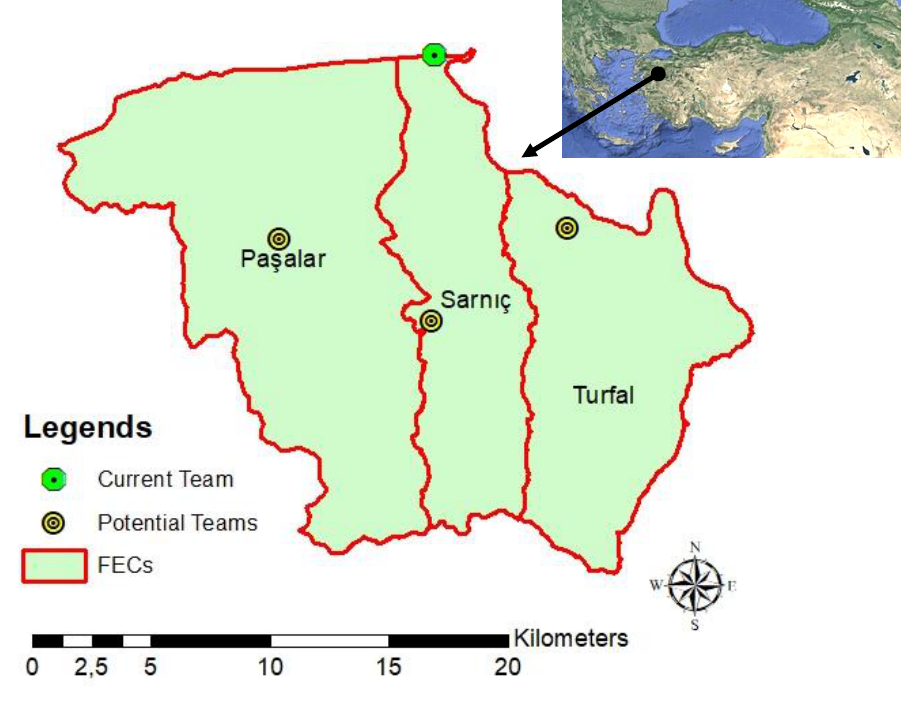
Figure 1. Current and potential firefighting teams in the study